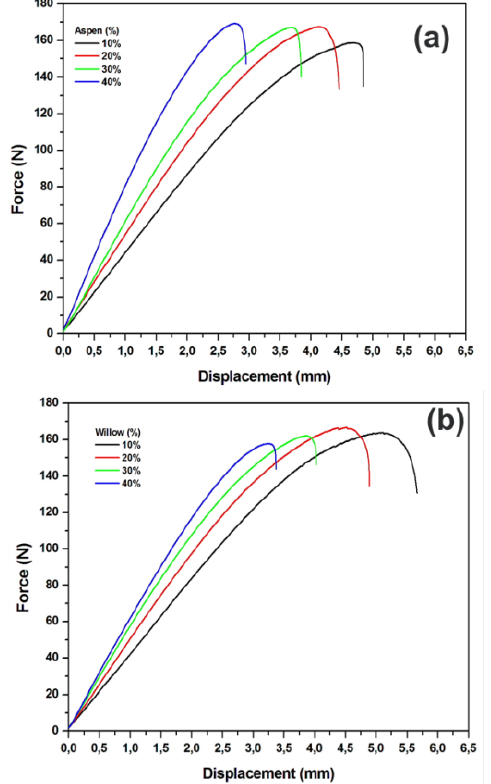
Figure 5. Load-displacement curves of biocomposites for bending strength for ( a ) aspen wood particles and ( b ) willow wood particles.